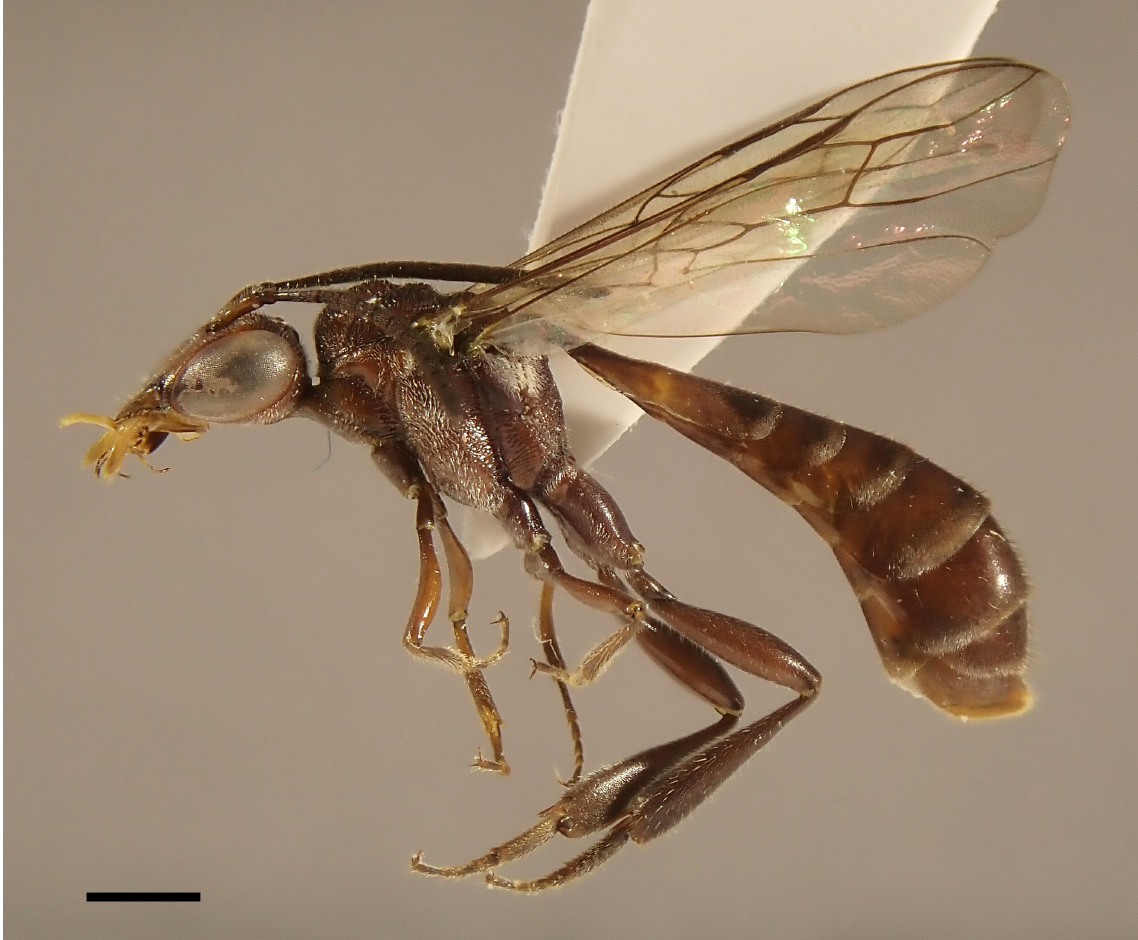
Fig. 10. Pseudofoenus caledonicus Jennings & Austin, 2005 (MNHN). Lateral habitus. Scale bar =